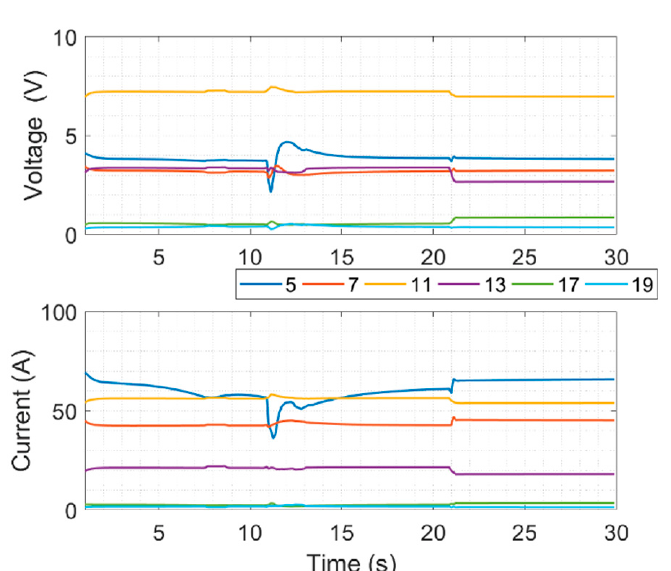
Figure 6. Change of states observed in the voltage (top) and current (bottom) harmonic phasors calculated on simulated data measured at PCC-LV. Breaker Brk_Trf1a was switched on at 11 s while Trf2 was still in service. Breaker Brk_Trf1b was switched on at 21 s.